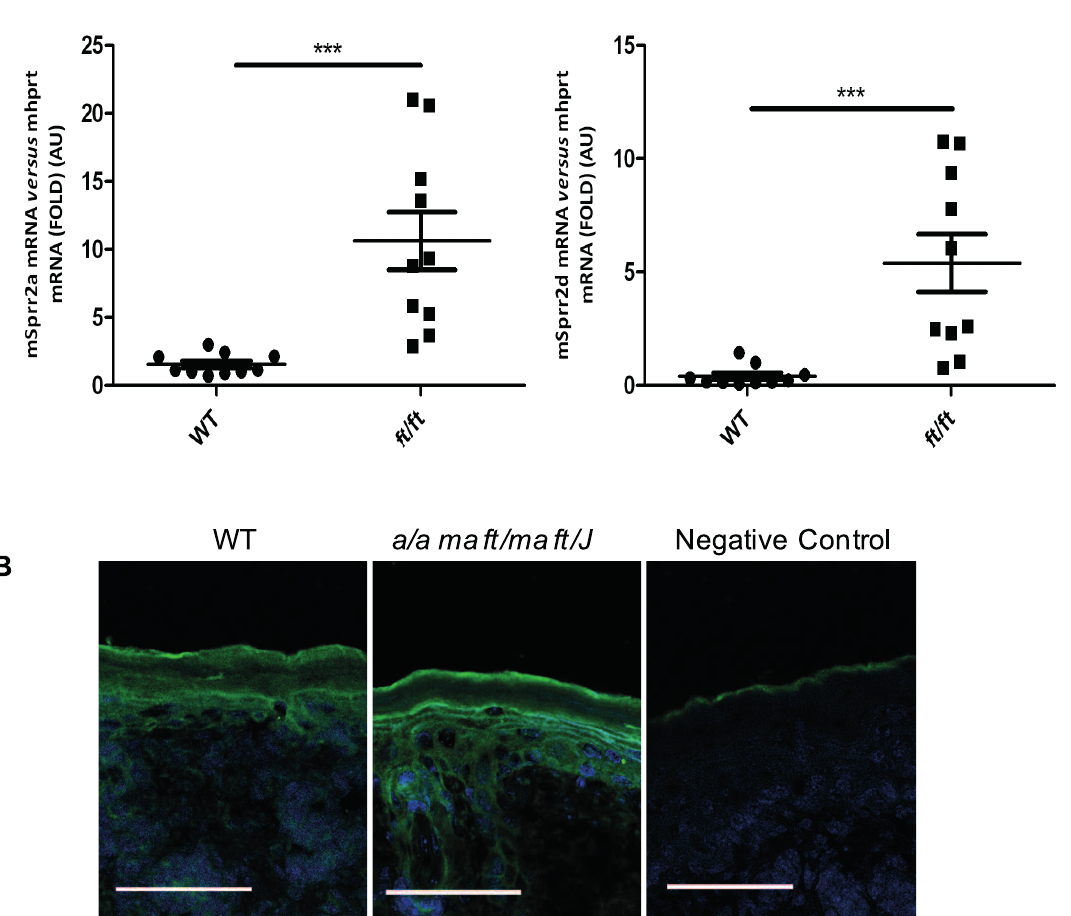
Figure 4. Increased Sprr2 expression in a/amaft/maft/J mouse epidermis. A. cDNA was prepared from P5 WT and a/a ma ft/ma ft/J (ft/ft) mice, real-time PCRs were performed using primers specific for Sprr2a and Sprr2d . Ct values were normalized with the hprt house-keeping gene.